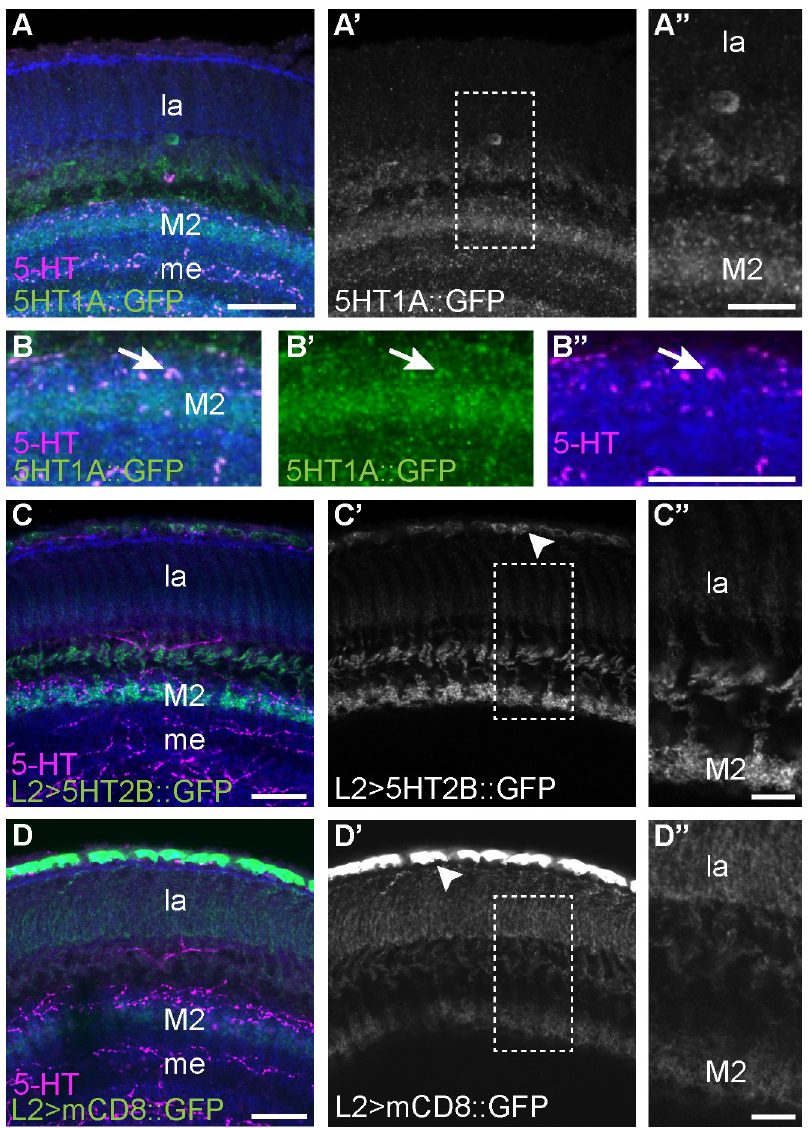
Fig 3. Serotonin receptors 5-HT1A and 5-HT2B are enriched in layer M2 of the medulla. ( A-A” ) 5-HT1A::GFP localized to layer M2 of the medulla, adjacent to some of the boutons in the medulla neuropil immunogenic for serotonin. Neuropil (anti-N-Cadherin, blue) and serotonin (magenta) labeling provide anatomical context for the lamina (la) and medulla (me). The region specified by the dotted lines in ( A’ ) is enlarged in ( A” ). ( B-B” ) In some cases, serotonin immunoreactive boutons appeared to be co-labeled rather than adjacent to 5-HT1A::GFP (arrow) possibly representing projections from serotonergic neurons in the central brain. ( C-C” ) Subcellular localization of 5-HT2B was visualized by expressing the fusion construct UAS-5-HT2B::sfGFP in L2 neurons specified by L2-split-Gal4. L2 > 5-HT2B::sfGFP labeling was stronger in the L2 terminals in medulla layer 2 (M2) compared to L2 projections in the lamina (la). Punctate GFP signal was observed in the L2 cell bodies (arrowhead). The region specified by the dotted lines in ( C’ ) is enlarged in ( C” ). ( D-D” ) For comparison, membrane-directed UAS-mCD8::GFP was expressed in L2 neurons. L2 > mCD8::GFP signal was similar in the medulla and lamina compartments. Strong GFP signal was observed in the cell bodies (arrowhead). The area within the dotted lines in ( D’ ) is enlarged in ( D” ). Scale bars are 20 μ m in A-A’ , B-B” , C-C’ and D-D’ . Scale bars are 10 μ m in A” and 8 μ m in both C” and D” . Biological replicates are N = 6 for 5-HT1A::GFP ( A-B ), N = 15 for L2 > 5-HT2B::sfGFP ( C-C” ), and N = 10 for L2 > mCD8::GFP ( D-D” ).